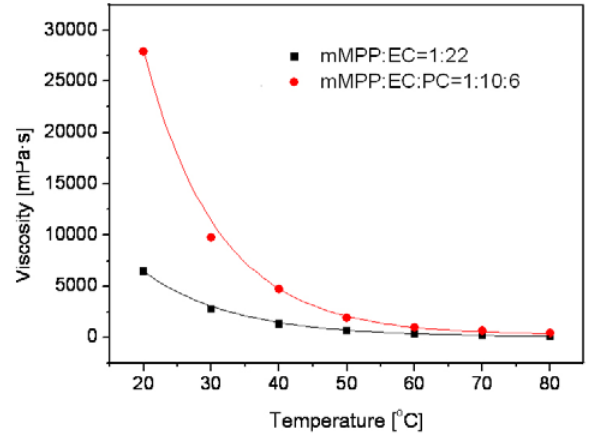
Fig. 6. Dependence of viscosity in function of temperature for the oligoetherols obtained in molar ratio as shown in insert.